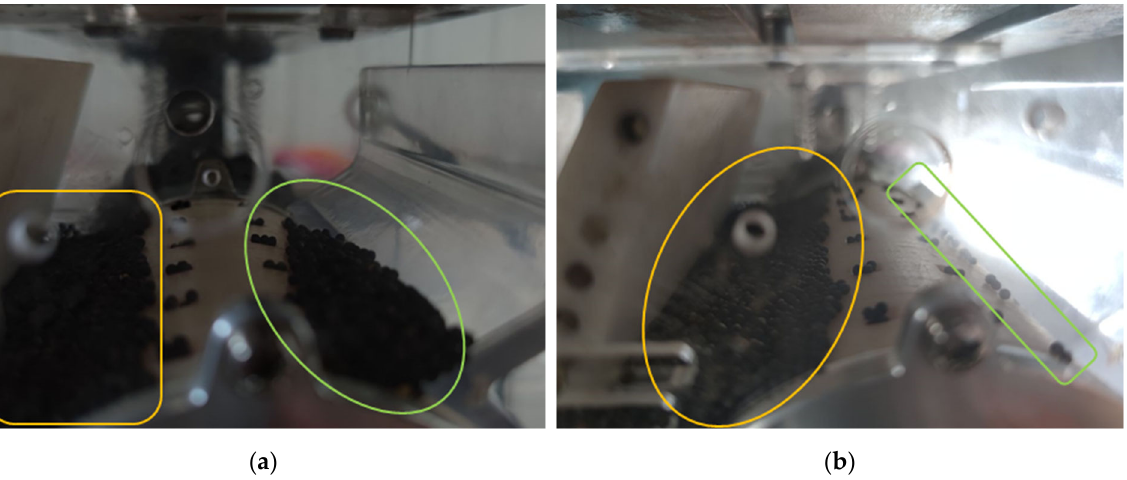
Figure 14. Effect of longitudinal distance on the number of retained seeds at 30 Hz: ( a ) h = 20 mm, and ( b ) h = 10 mm. Note: The yellow line indicates the seeds in the seed-filling area, and the green line indicates the retained seeds.